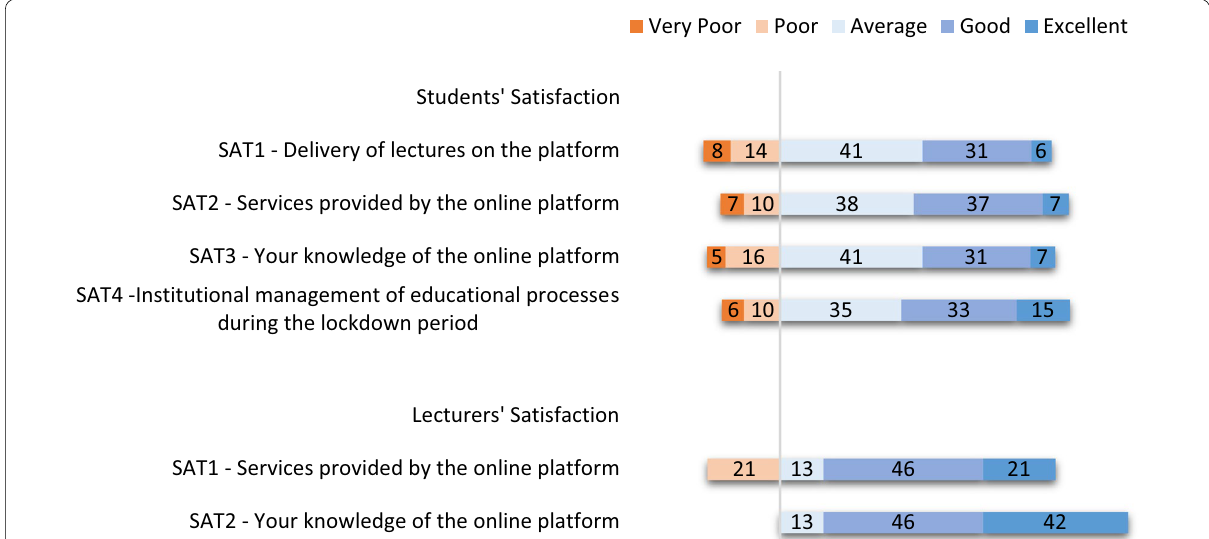
Fig. 4 Diverging stacked bar chart showing students ( n Likert-scale questionnaires. The complete statements from the questionnaire are available in Additional file 1: Tables S1 and S2